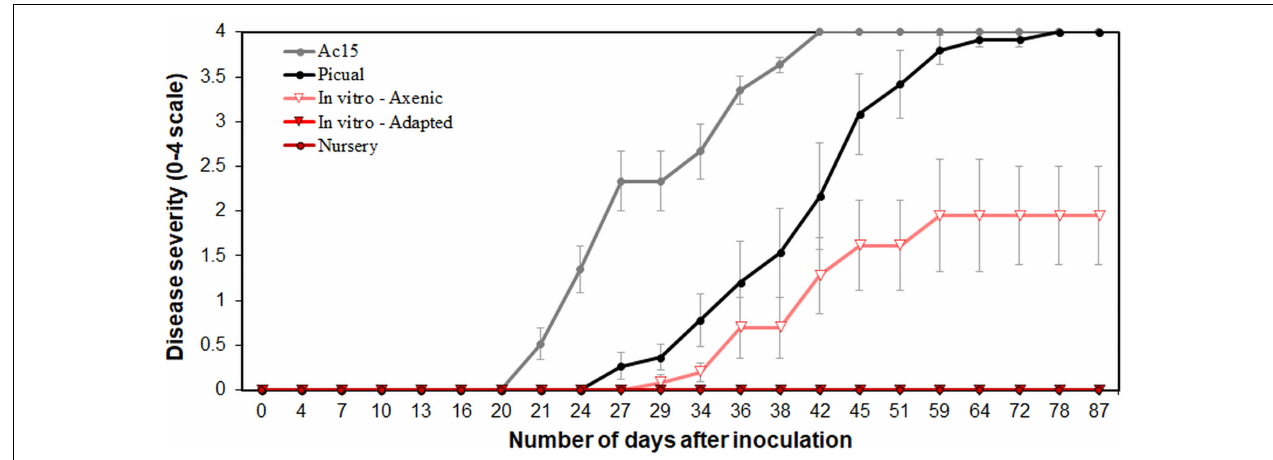
FIGURE 1 | Verticillium wilt disease progression in “Ac-18” in vitro (standard and adapted) and nursery propagated olive plants inoculated with the defoliating pathotype of Verticillium dahliae . “Picual” and “Ac-15” olive genotypes were used as positive controls to determine the inoculation success and development of the disease. Each point represents the mean disease severity (0–4 scale: 0 = healthy, 4 = dead plant) of data and error bars show the standard error from six plants per treatment.